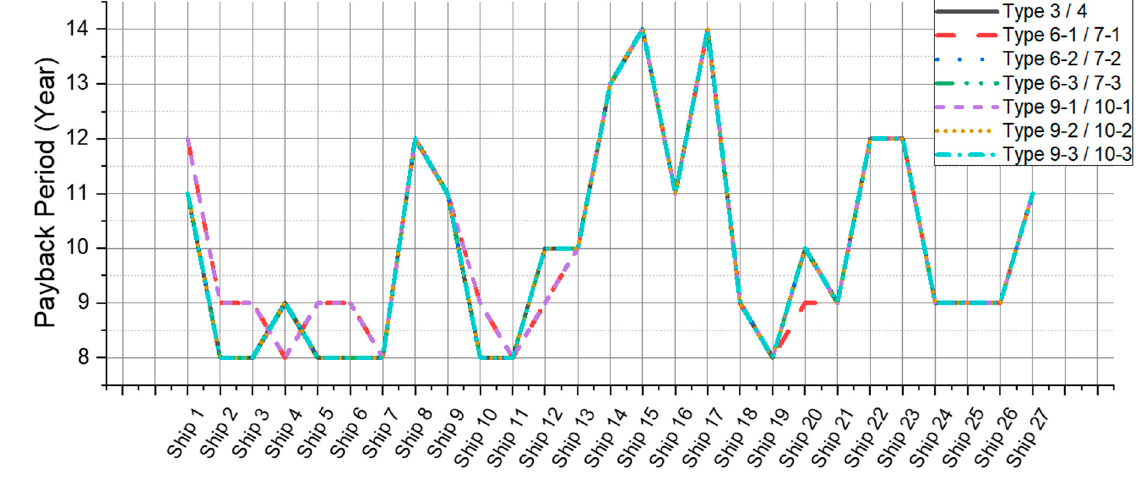
Figure 7. Payback period of solar PV system.